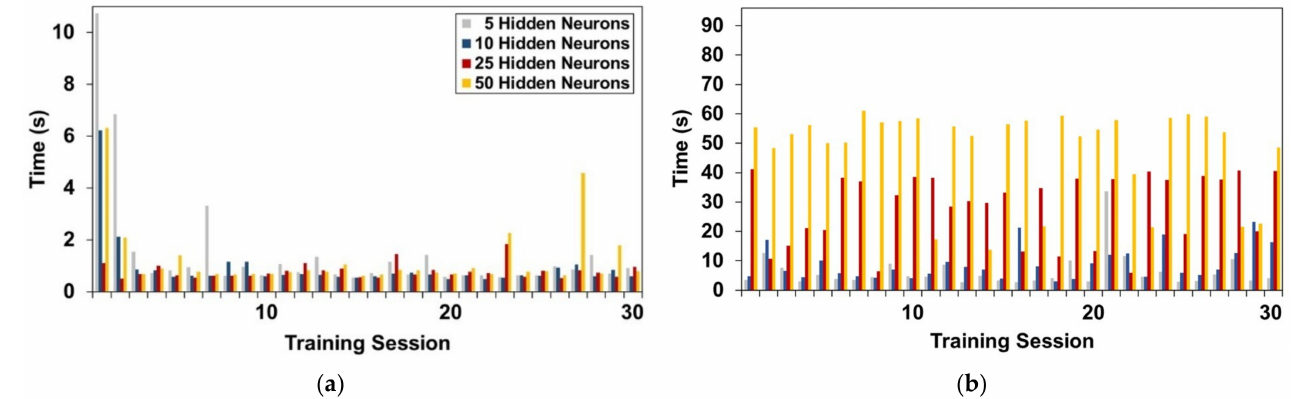
Figure 14. Duration of each training session of FFNN2 with a single hidden layer for: ( a ) LM training algorithm; ( b ) BR training